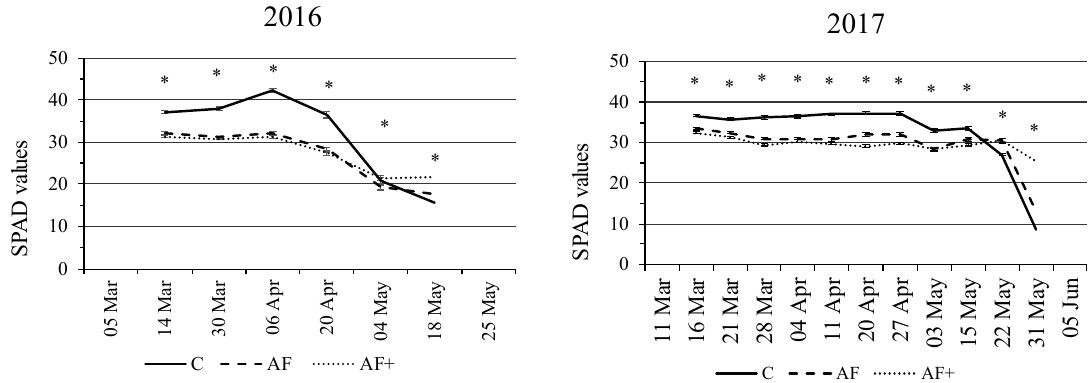
Figure 2. Leaf (last fully expanded) chlorophyll content measured as SPAD (soil plant analysis development) units (±SE) in three treatments as the average of 25 genotypes (6 plants were measured for each genotype/replicate) in the 2016 and 2017 growing seasons. Asterisks indicate significant differences between treatments for each date (Tukey’s HSD test, p ≤ 0.05). C: controls; AF: pruned olive trees; AF+: un-pruned olive trees.